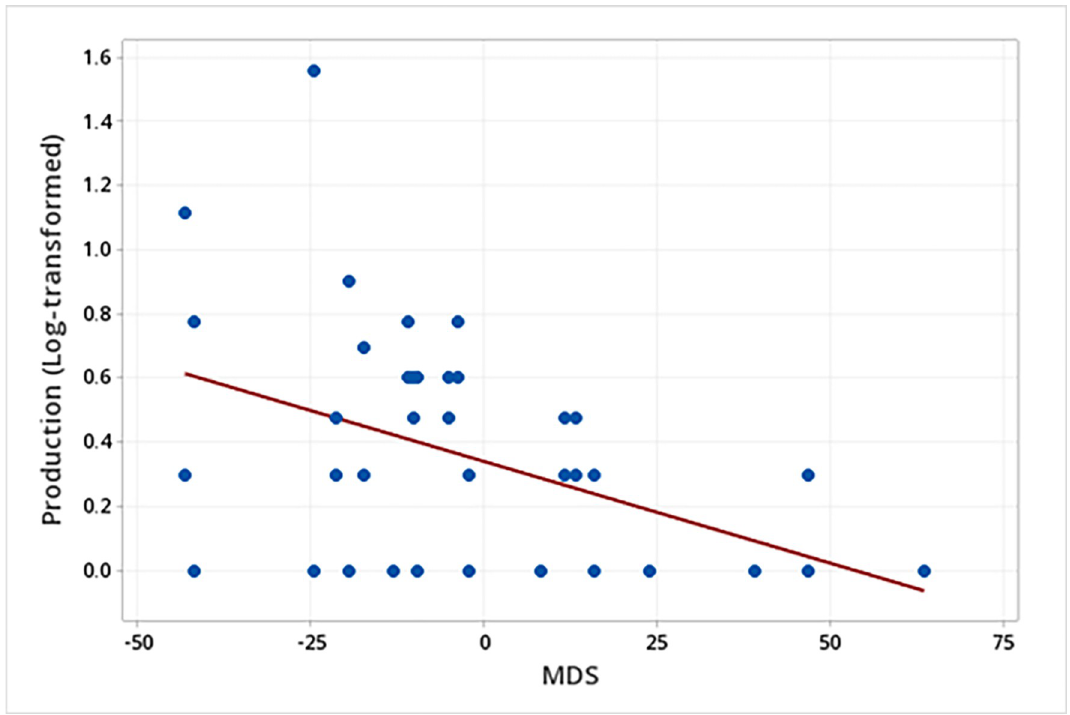
Fig 3. Relationship between the sender’s social rank (MDS) and the production of multimodal signals when displaying submissive behaviors.